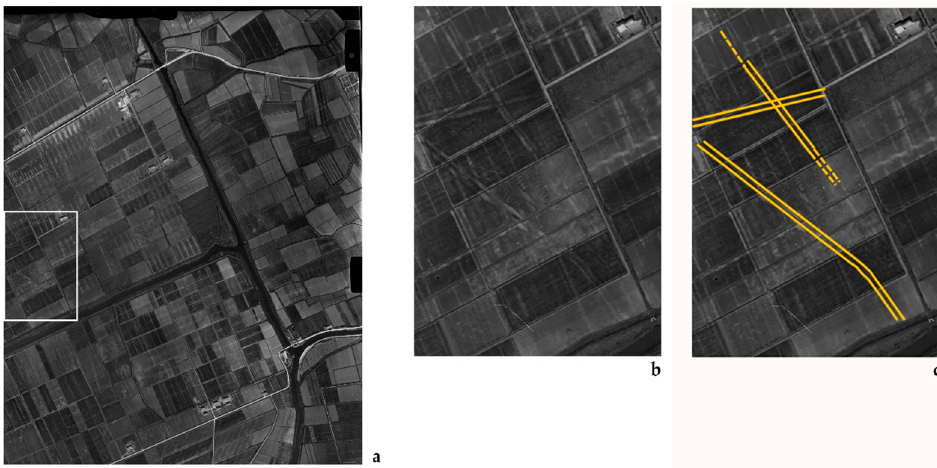
Figure 2. ( a ) 1938 aerial photo depicting the Aquileian landscape before post-war land rearrangements: higher frequency platting is evident; ( b , c ) zoom: marks referring to previous lands arrangements and roadways.